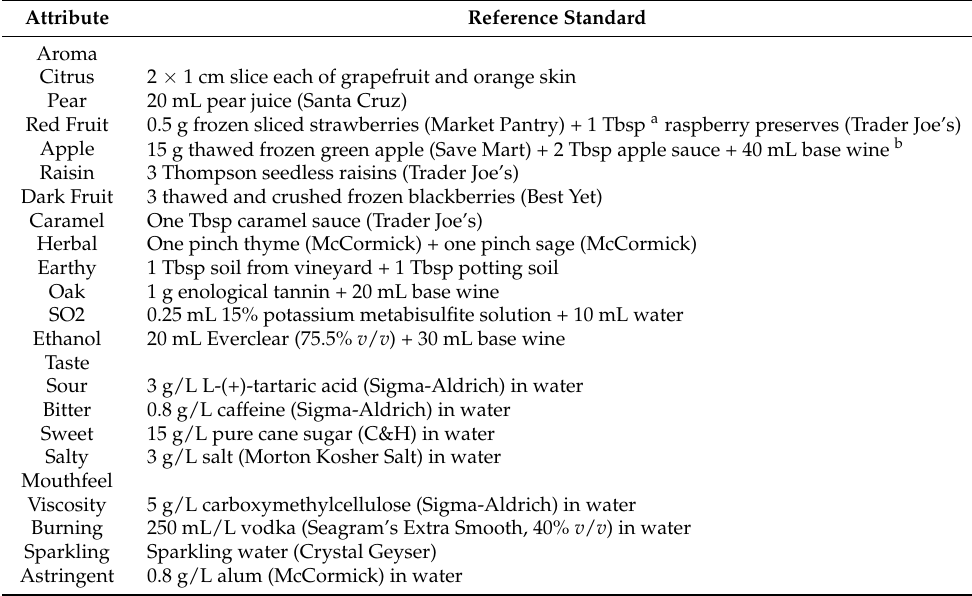
Table 1. Attributes and corresponding reference standards for the Grenache descriptive analy- sis